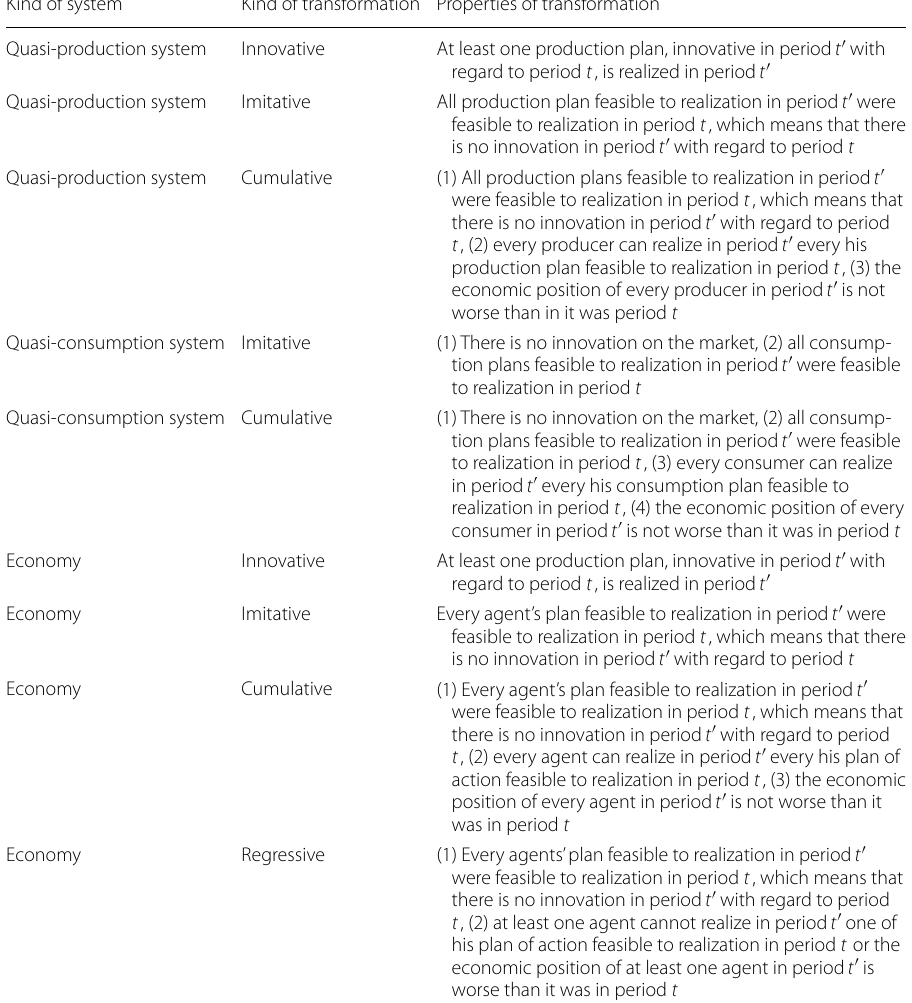
Table 1 Summary of properties of transformation of the economic structures presented Kind of